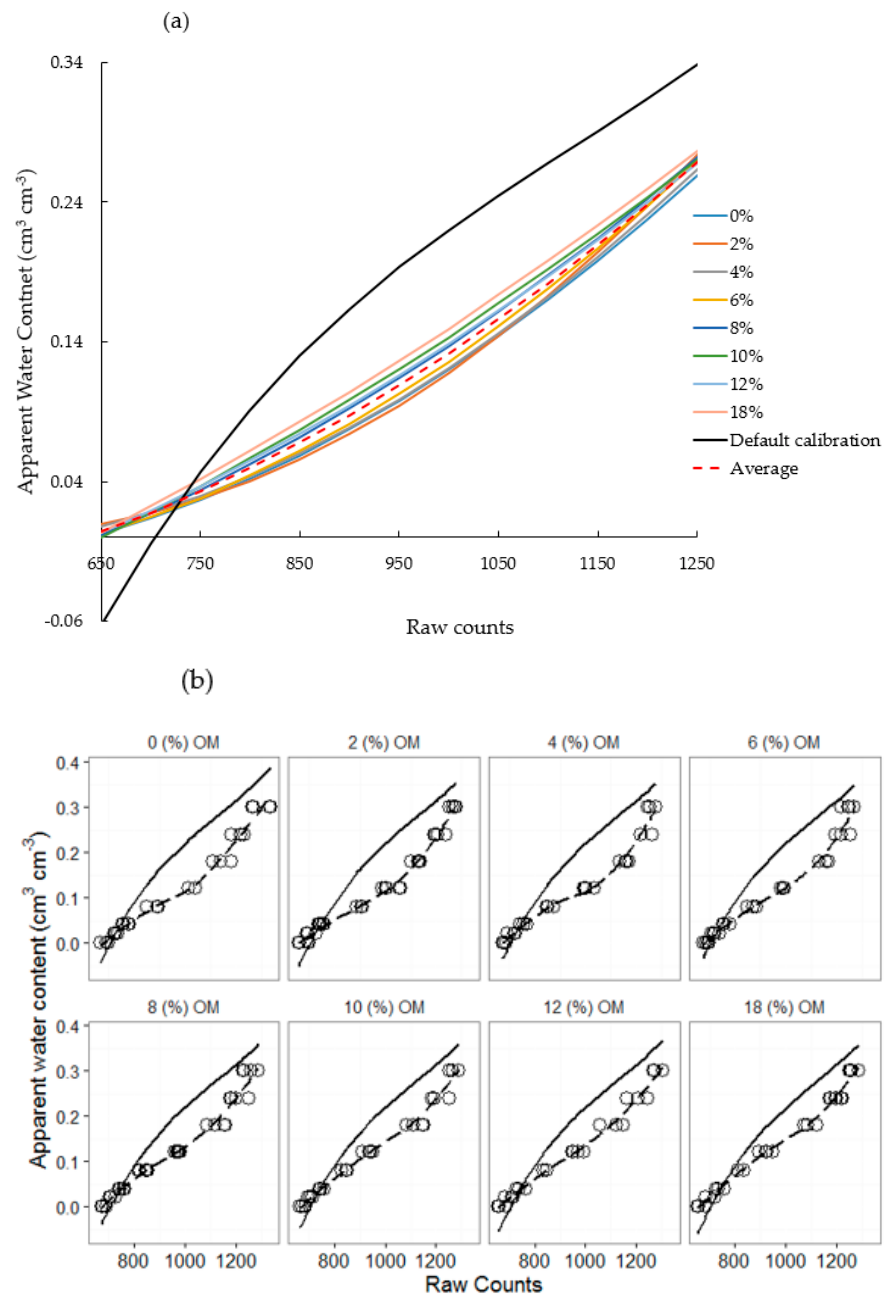
Figure 4. Actual (open circles) and apparent water contents (solid black lines) regressed against SWCM raw counts for different organic matter levels; ( a ) all plots combined and ( b ) separate plots for each organic matter level.